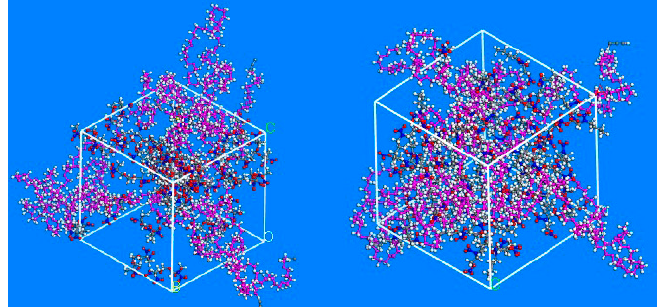
Figure 1. Chemical models of Alkynyl-terminated polyethylene oxide − tetrahydrofuran (ATPET) & A3 (bis-(2,2-dinitropropy) acetal (BDNPA)/bis-(2,2-dinitropropyl) formal (BDNPF) = 1/1) ( left ) and ATPET & Bu-NENA ( right ).